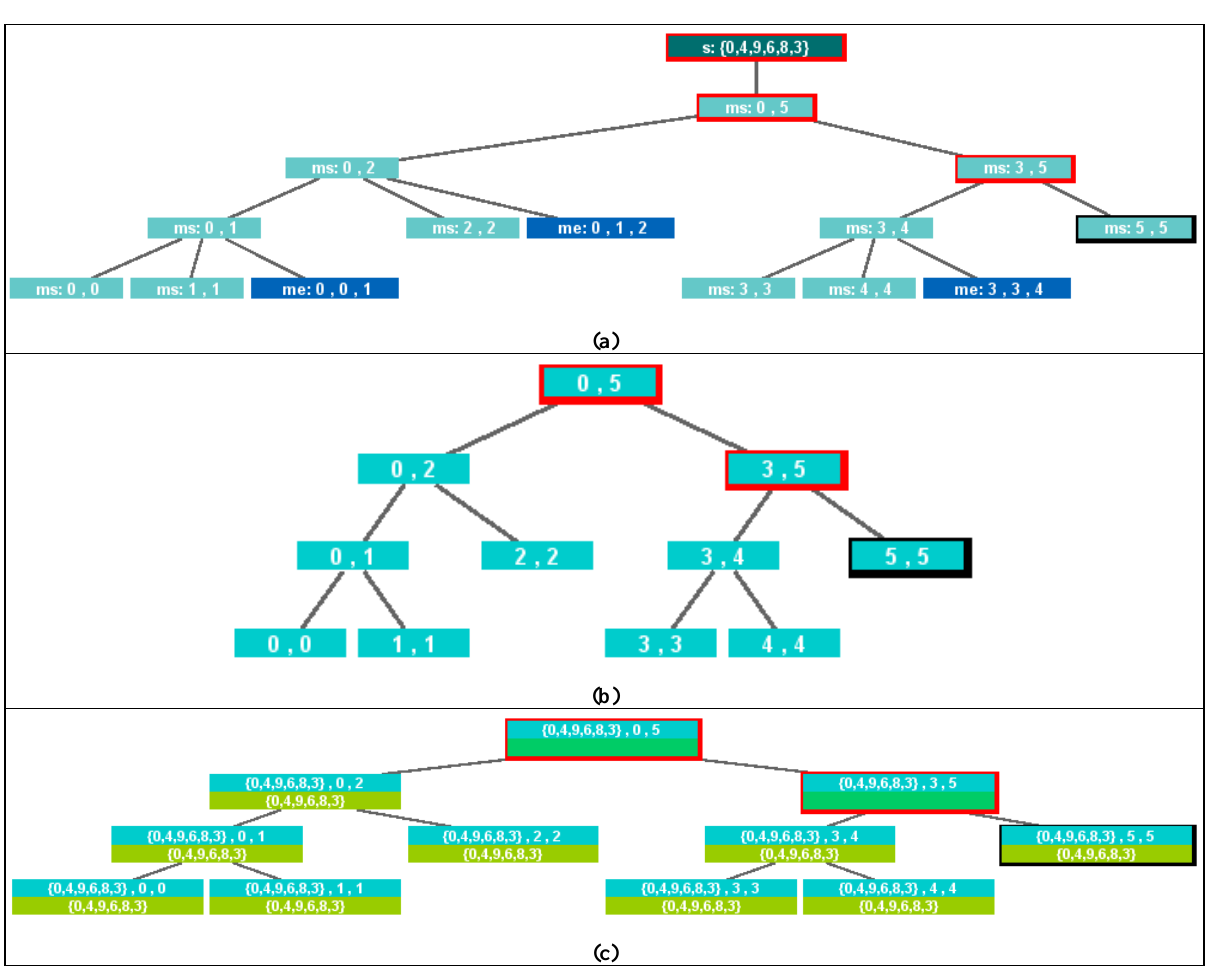
Figure 5. Recursion tree variants for mergesort